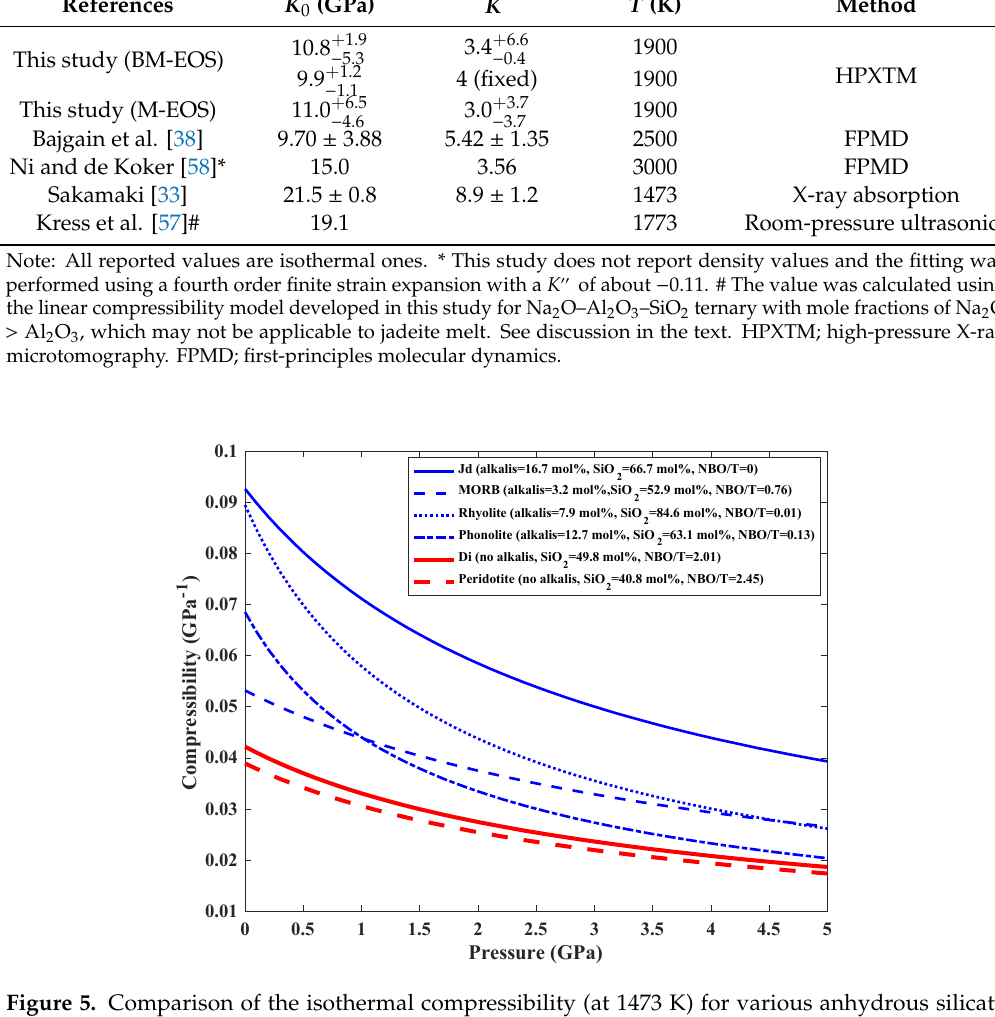
Figure 5. Comparison of the isothermal compressibility (at 1473 K) for various anhydrous silicate melts at high pressures. Data for mid-ocean ridge basalt (MORB), rhyolite, phonolite, diopside (Di) and peridotite melts are from Agee [1], Malfait et al. [36], Seifert et al. [35], Ai and Lange [60] and Sakamaki et al. [59], respectively. The compressibility curve for jadeite melt was calculated using the best-fit values from BM-EOS. Blue curves are for polymerized melts based on the non-bridging oxygen (NBO)/tetrahedrally coordinated cations (T) ratios, and red curves are for depolymerized melts.